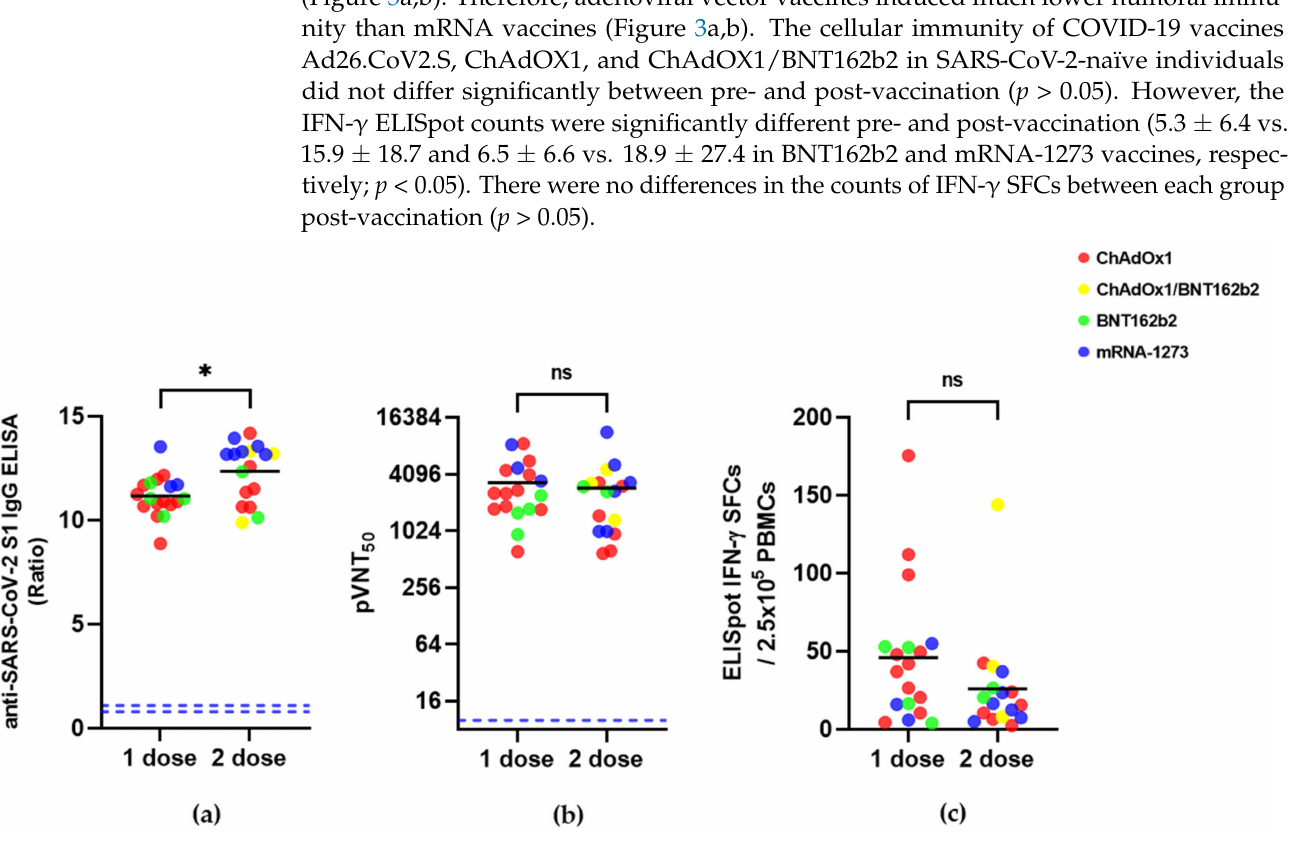
Figure 2. Humoral and cellular immune responses in SARS-CoV-2-recovered individuals vaccinated with a single- or double-dose COVID-19 vaccine. ( a ) SARS-CoV-2 S1 IgG ELISA ratio; ( b ) pVNT 50 titer; ( c ) IFN- γ ELISpot counts. The blue dashed line indicates the cutoff (S1-IgG = 0.8 for negative and 1.1 for positive, pVNT 50 = 10). p values were determined using the Mann–Whitney test. ns, p > 0.05, * p < 0.05. Table 3. Mean values of humoral and cellular immune responses in SARS-CoV-2-recovered individu- als vaccinated with a single or double COVID-19 vaccine